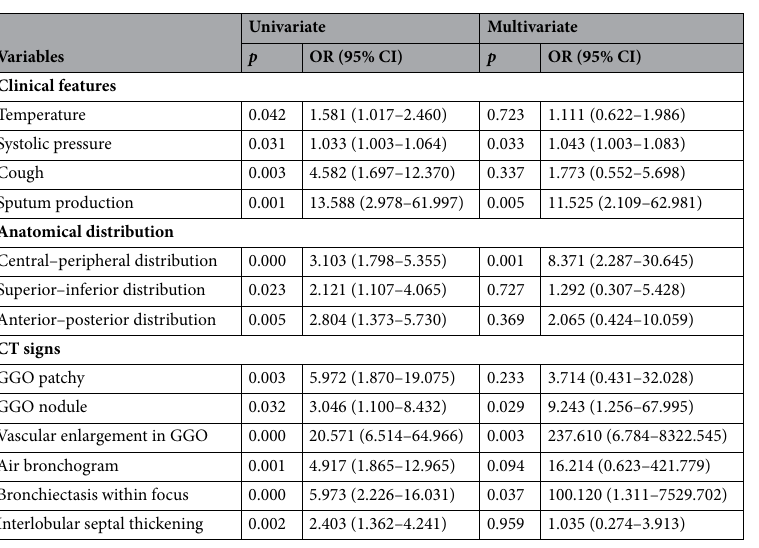
Table 3. Univariate and multivariate analysis of clinical features and CT features for distinguishing COVID-19 and influenza